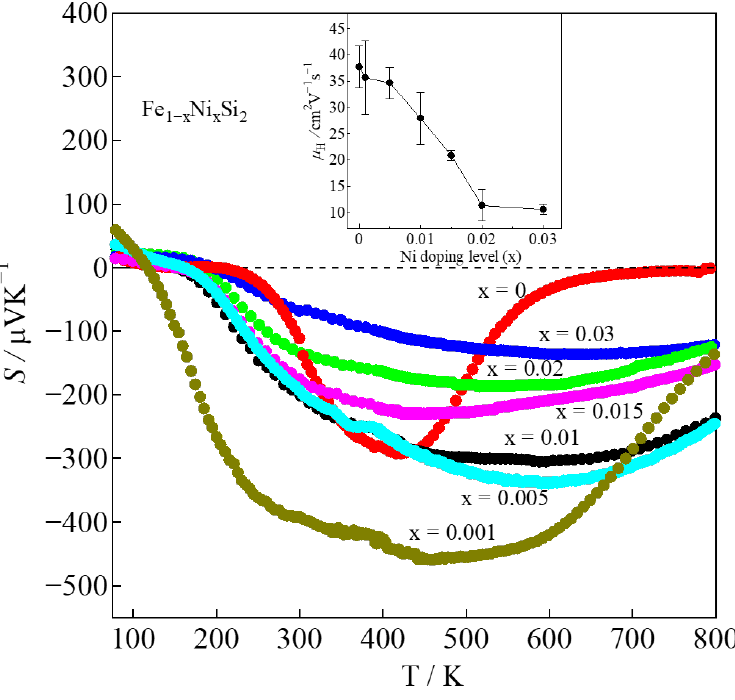
Figure 6. Seebeck coefficient of β -Fe 1−x Ni x Si 2 (0 ≤ x ≤ 0.03) with respect to temperature, where the carrier mobility, μ H , at 300 K is plotted in the inset.